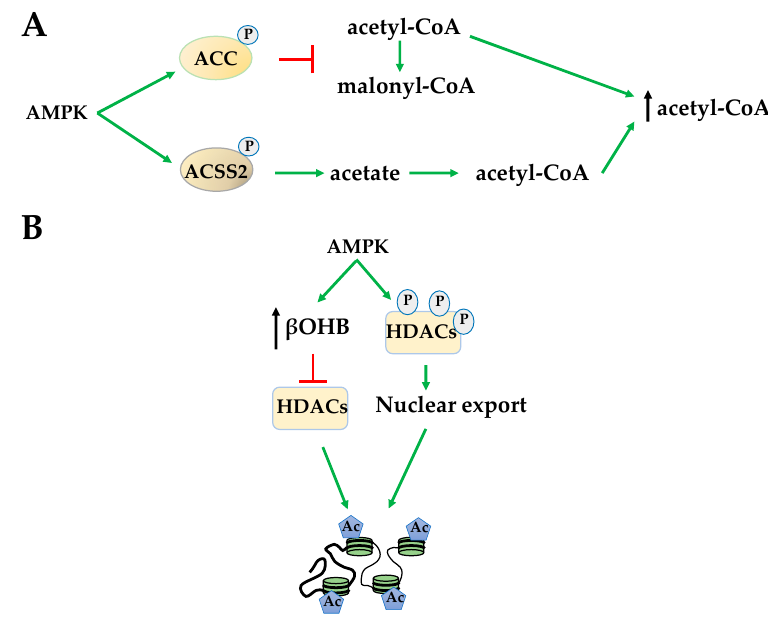
Figure 2. AMPK activation increases acetyl-CoA and promotes histone acetylation. ( A ) Through phosphorylation, AMPK inhibits acetyl-CoA carboxylase (ACC) while activating acetyl-CoA synthetase short-chain family member 2 (ACSS2) to increase acetyl-CoA availability for acetylation; ( B ) AMPK increases β -hydroxybutyrate ( β OHB) to inhibit histone deacetylases (HDACs) and promotes HDAC nuclear export via hyperphosphorylation. Both of these events increase histone acetylation.